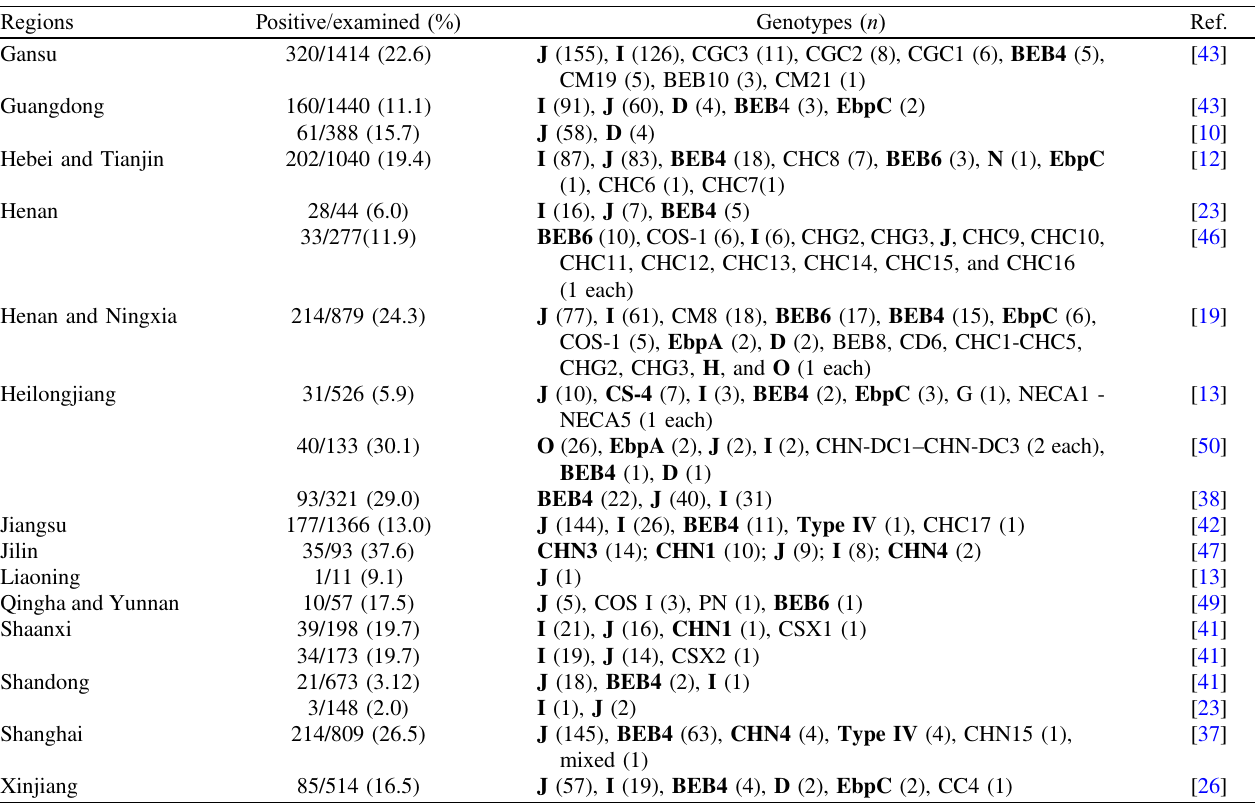
Table 3. ITS genotypes of natural Enterocytozoon bieneusi infections identi fi ed in cattle in China.